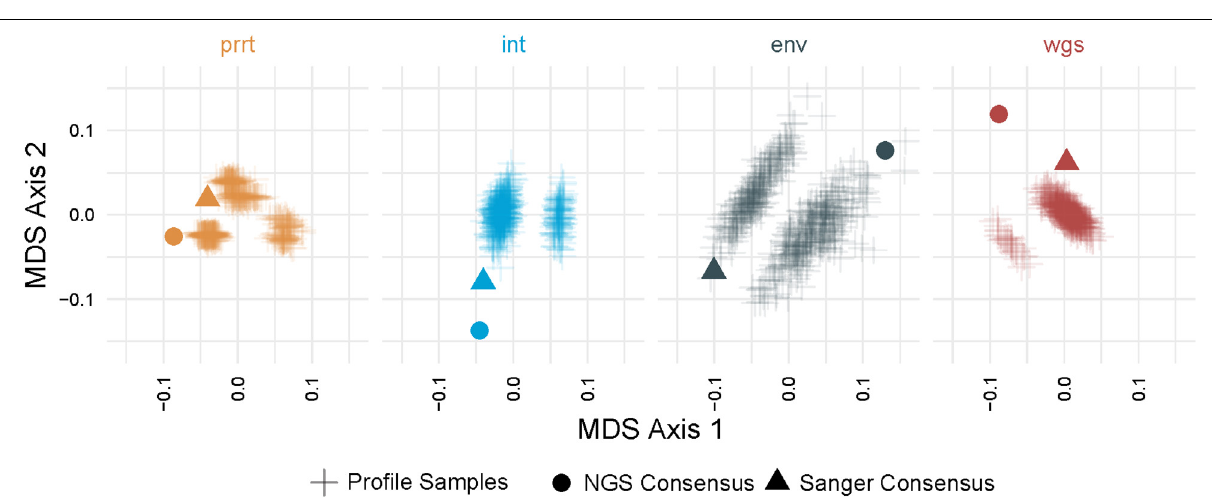
consensus sequences (31) or profile sampling (43); and detected fewer clusters in each region except env . Cluster support values were higher for clusters detected by phylogenies of both NGS